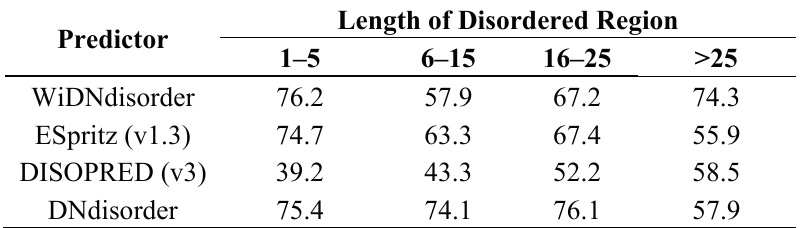
Table 4. Recall of disordered predictions by disorder region length on the DO1111_TEST dataset.